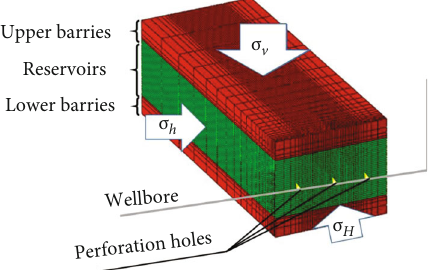
Figure 2: Schematic of fracture propagation model.